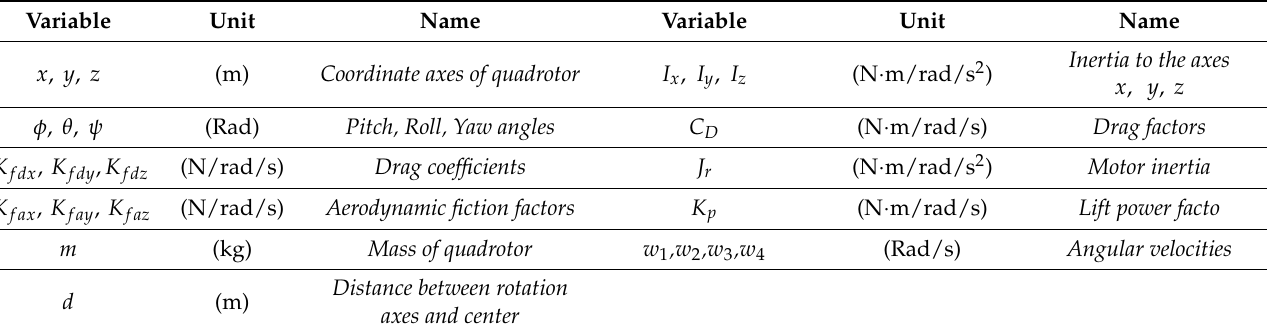
Table 1. Parameters of dynamical model of quadrotor